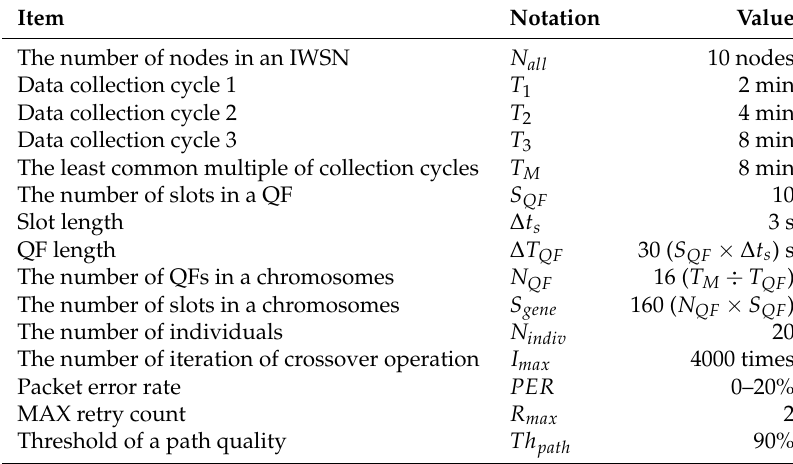
Table 3. Simulation